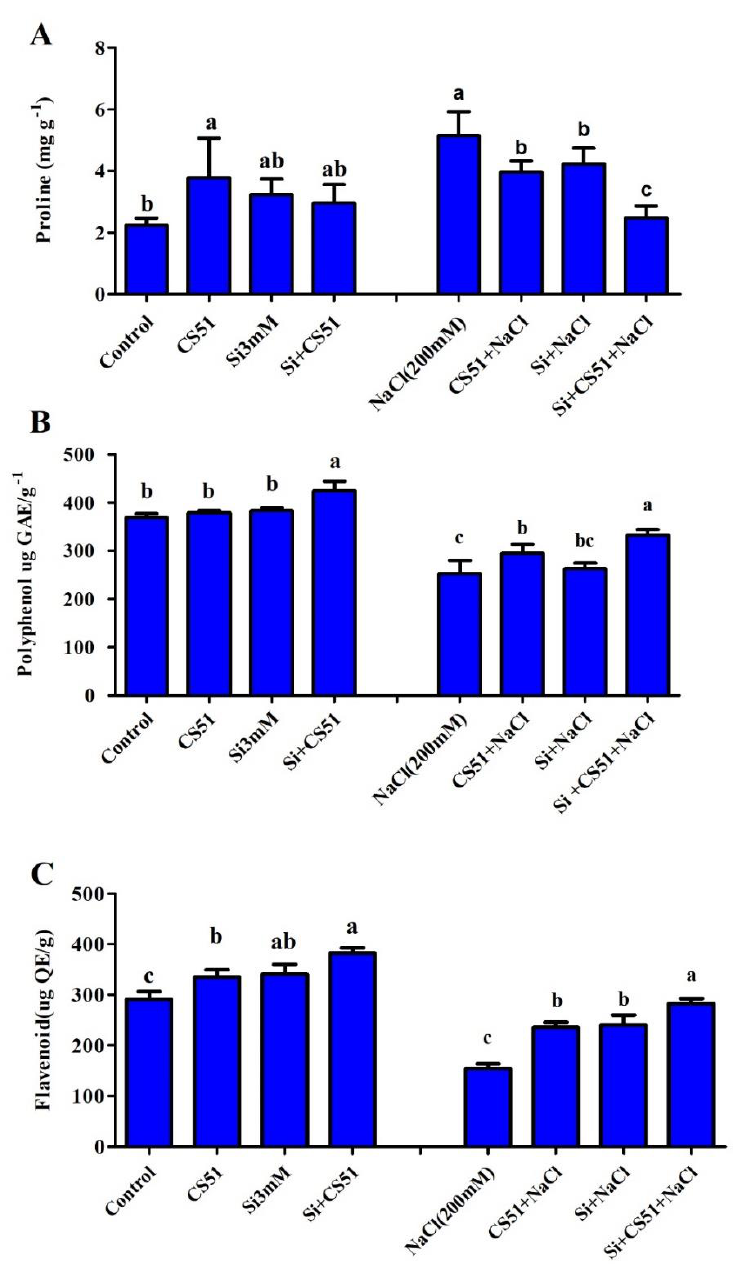
Figure 5. Quantification of ( A ) proline content, ( B ) polyphenol oxidase (PPO), and ( C ) flavonoid content of maize grown in elevated NaCl (200 mM) treated with isolate CS51 and Si. Each value represents the mean ± SD of three replicates. Different letters on columns with error bars (mean ± SD) represent a significant difference among the treatments evaluated by Duncan’s Multiple Range Test (DMRT).